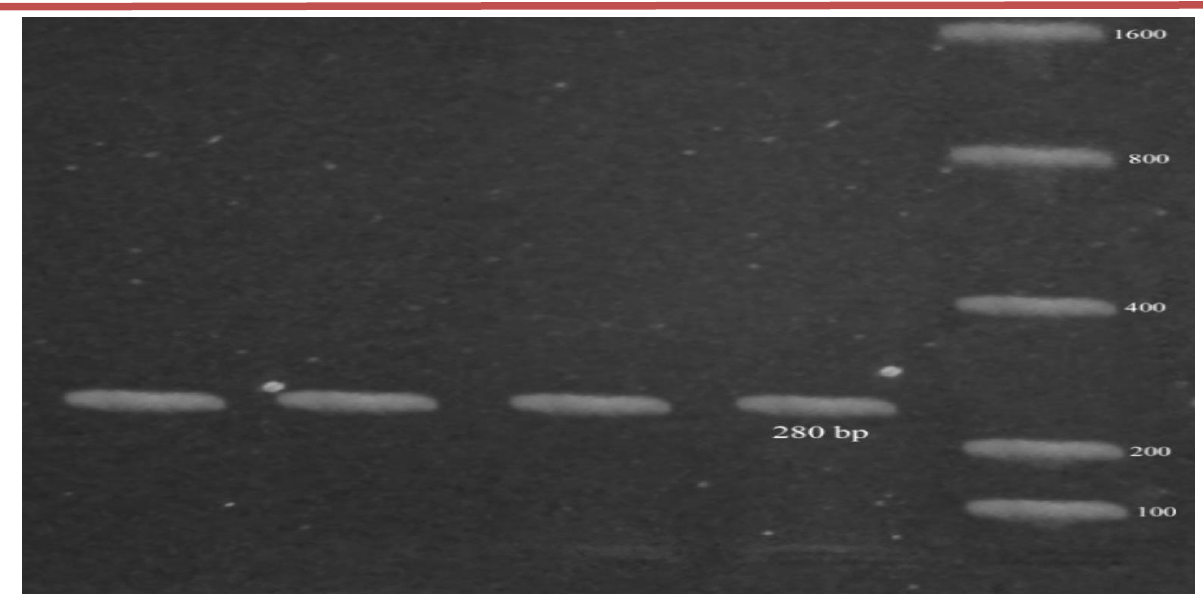
Figure-1- Results of DNA electrophoresis after